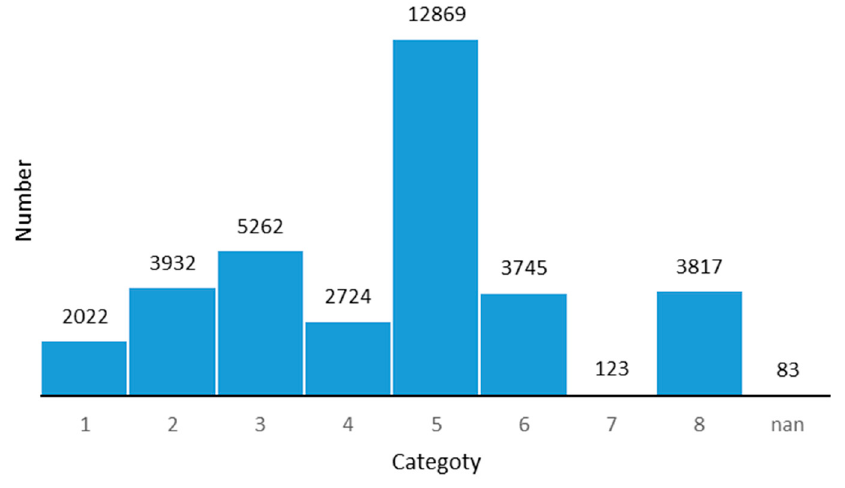
Figure 2. Data distribution in the train set of ice environment traffic sign recognition benchmark (ITSRB).